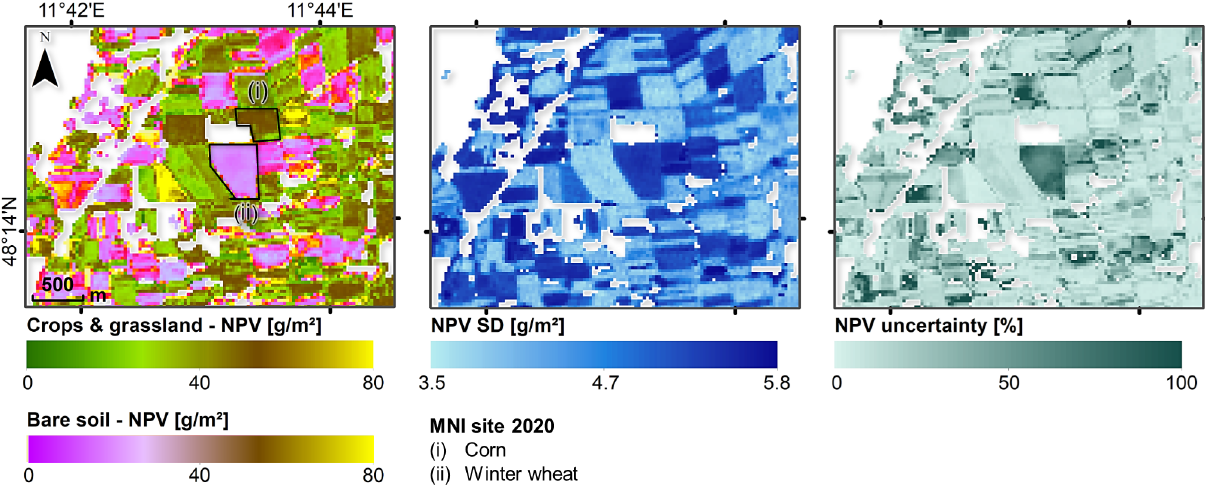
Figure 9. Zoom-in mapping example of non-photosynthetic cropland biomass estimation over long-term Munich-North-Isar test site. Left: non-photosynthetic cropland/NPV biomass estimates over crops and grasslands, and bare soils, middle: associated absolute uncertainties in form of standard deviation and right: relative uncertainty calculated with the coefficient of variation (CV). The two harvested MNI test fields of winter wheat and corn are also indicated. White zones were masked out based on image